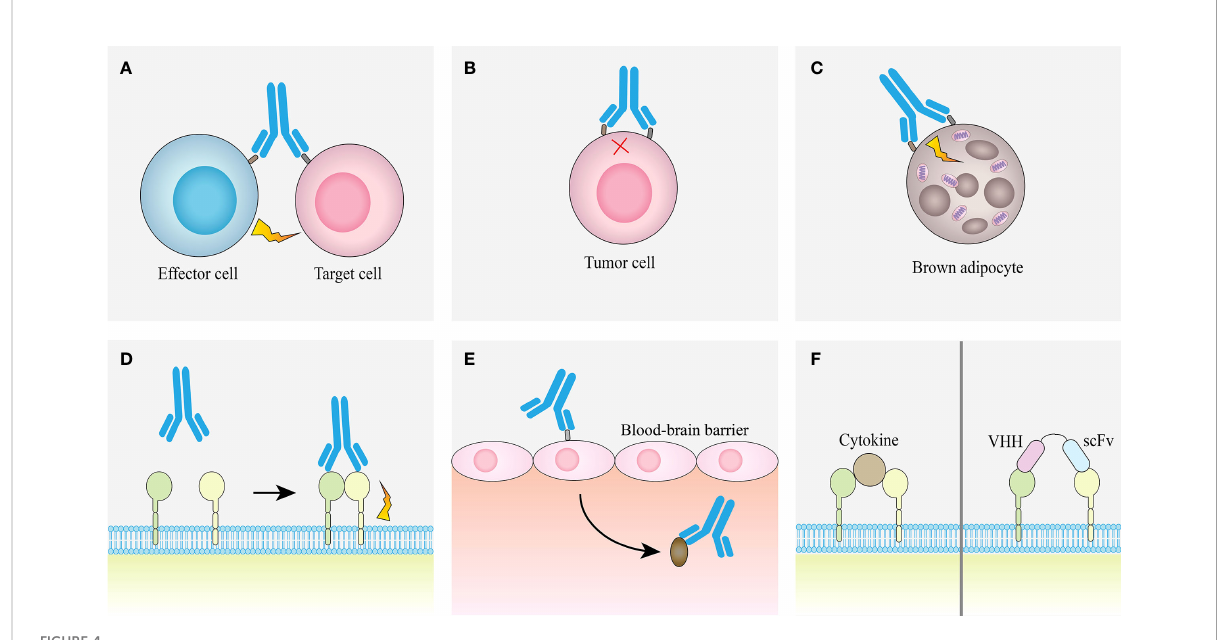
FIGURE 4 Examples of obligate mechanisms of action of bsAbs. (A) Linking T cells and tumor cells. (B) Receptor inhibition. (C) Receptor activation. (D) Analoging cofactor. (E) Using target to transport. (F) Surrogate cytokine